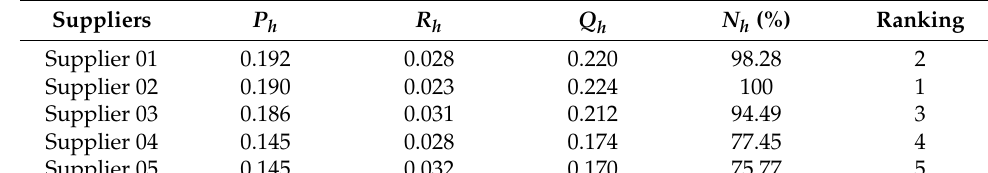
Table 12. The evaluation of the utility degree of G-COPRAS.